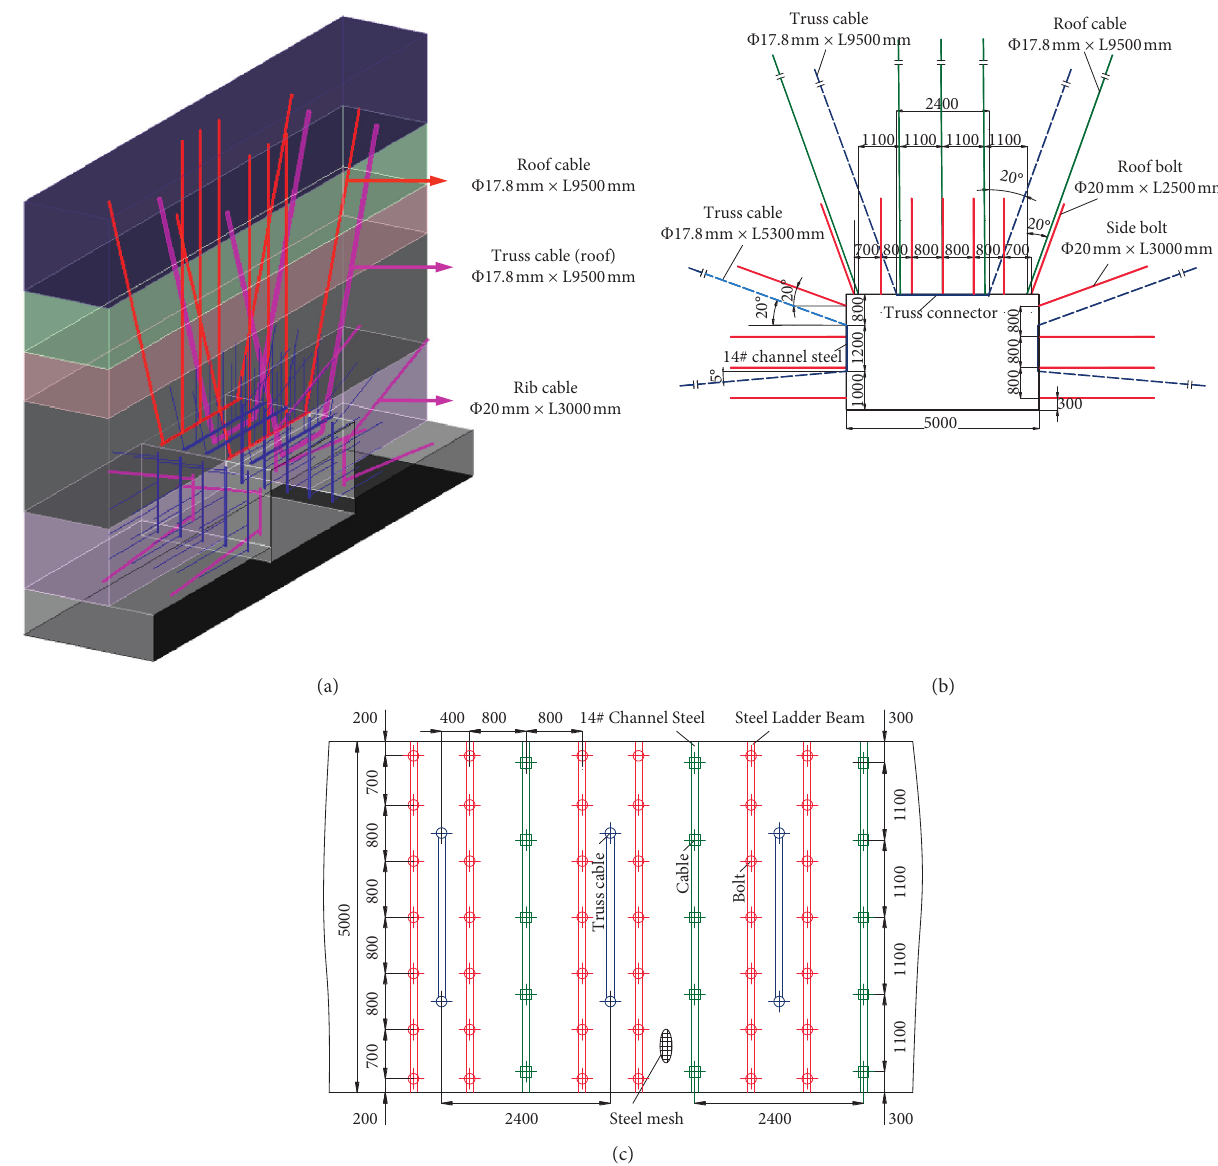
Figure 15: Support diagram of gas tailgate (unit: